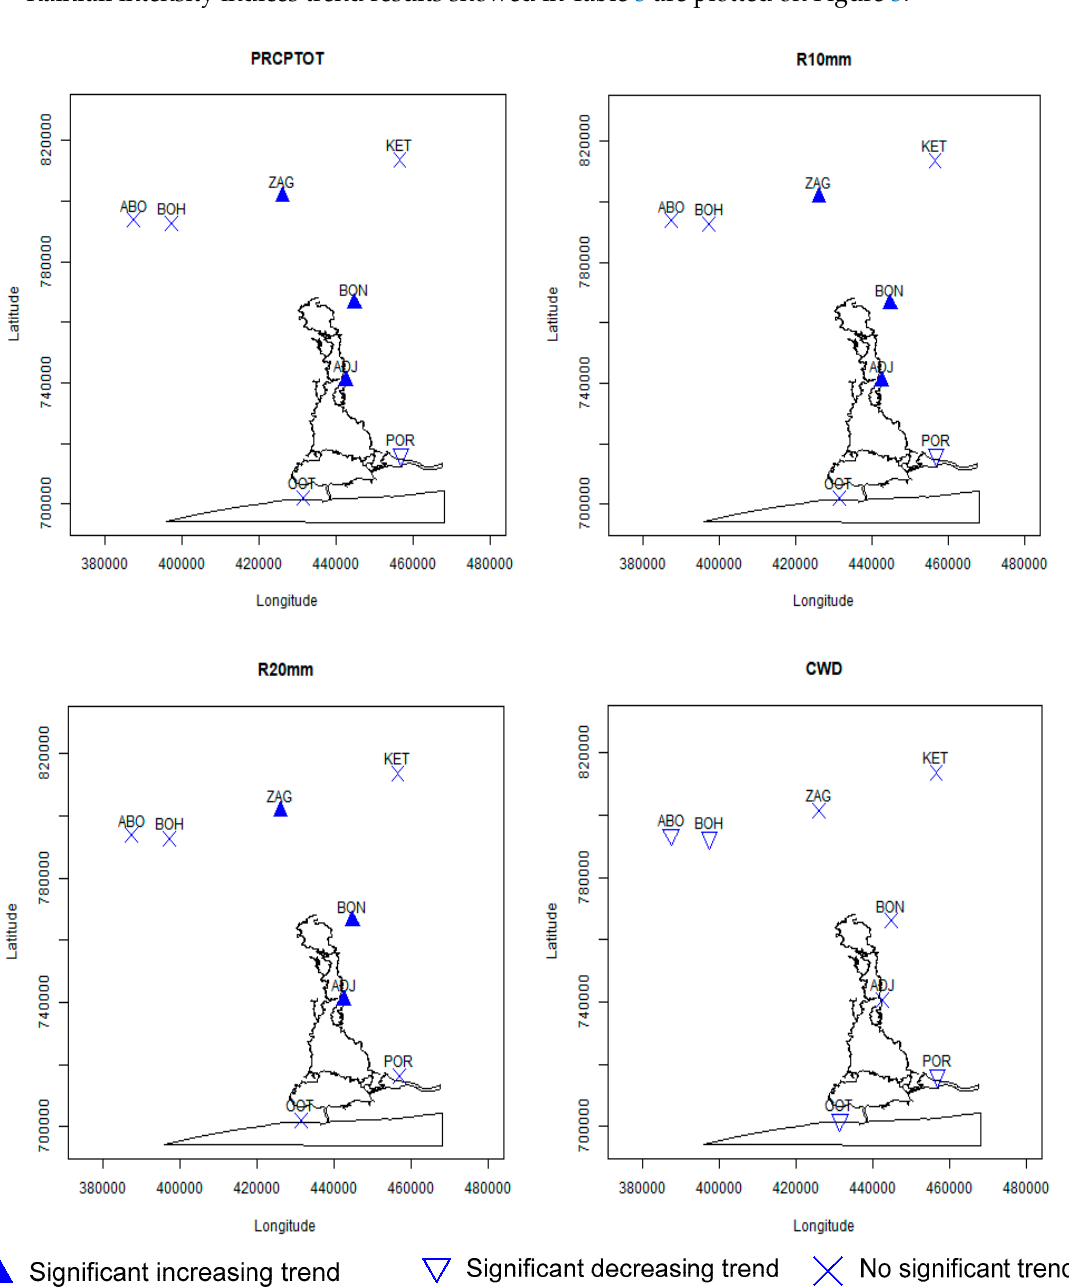
Figure 3. Plot of Annual total precipitation (PRCPTOT), R10mm, R20mm trend, and consecutive wet day (CWD) over Ouémé Delta.